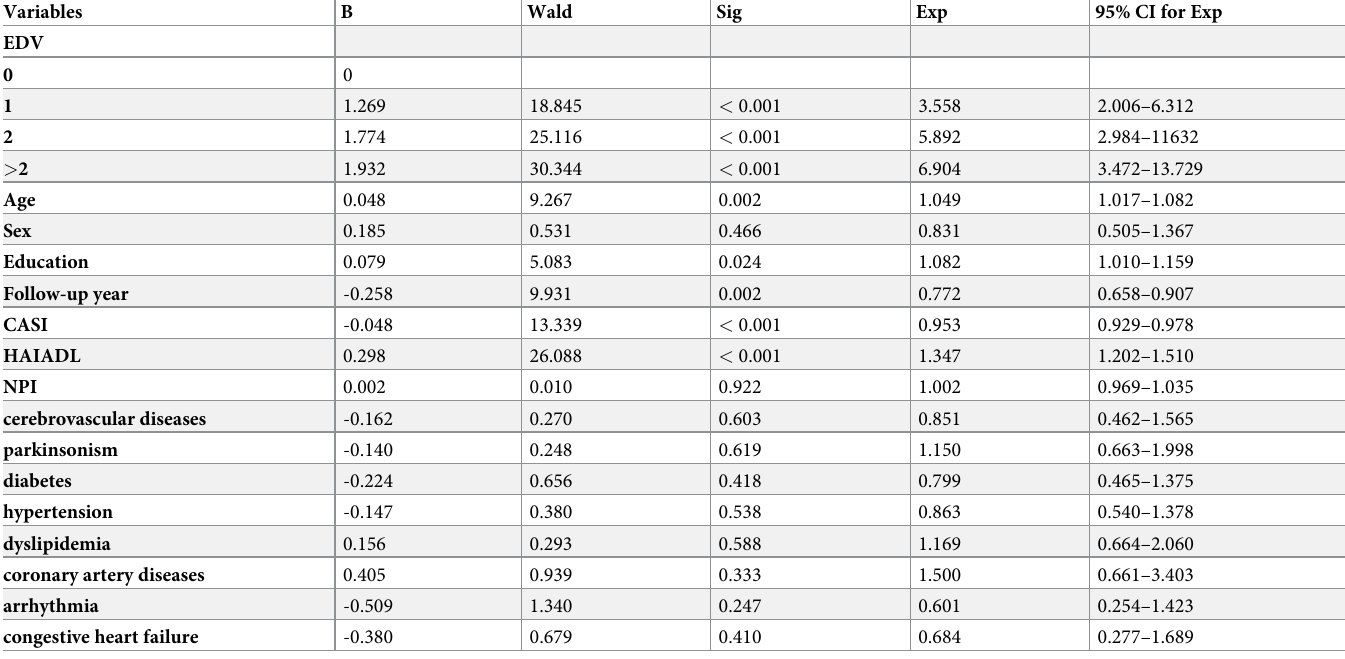
Table 2. Multiple logistic regression analysis was adopted for investigating the contribution of EDV and other variables of the predemented participants to convert to dementia. Hazzard ratios (HR) were adjusted for age, sex, education, follow-up year, CASI, HAIADL, NPI, cerebrovascular diseases, parkinsonism, diabetes, hyperten- sion, dyslipidemia, coronary artery diseases, arrhythmia, and congestive heart failure.